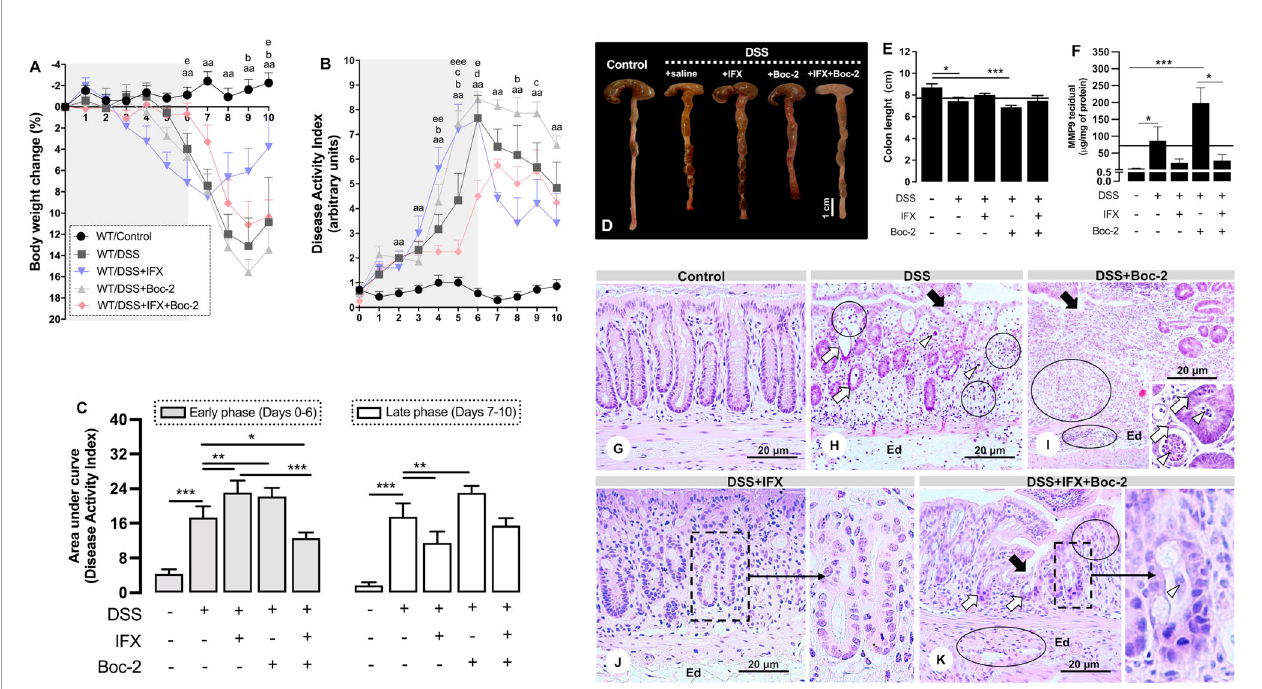
FIGURE 2 | Formyl peptide receptor (FPR) blockade impairs clinical and histological improvements induced by in fl iximab (IFX) during colitis. (A) Loss of body weight. (B) Disease Activity Index (DAI). (C) Area under the curve from DAI, early and late phases. (D, E) Colon length and anatomic changes. (F) Colonic MMP-9 levels. Mean of all samples ( continuous lines ). Bar , 1 cm. aa p < 0.01 (DSS vs. Control); b p < 0.05 (DSS+IFX vs. DSS); c p < 0.05 (DSS+Boc-2 vs. DSS); d p < 0.05 (DSS+IFX+Boc-2 vs. DSS); e p < 0.05, ee p < 0.01, eee p < 0.001 (DSS+IFX+Boc-2 vs. DSS+IFX). * p < 0.05, ** p < 0.01, *** p < 0.001. n = 4 – 6 mice/group. Results are expressed as the mean ± SEM. (G – K) Histopathology in wild-type (WT) groups. Ulcer ( black arrows ), altered crypts ( white arrows ), crypt abscesses ( white arrowheads ), edema ( Ed ), and in fl ammatory in fi ltrate ( circles ). Staining, hematoxylin – eosin; embedding, paraf fi n; sections, 3 m m. Bars , 20 m